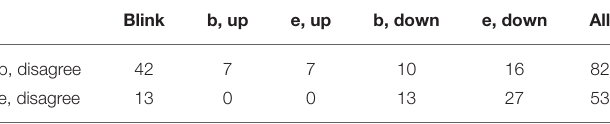
TABLE 6 | Emblem/disagree—frequency of items from the gaze class.